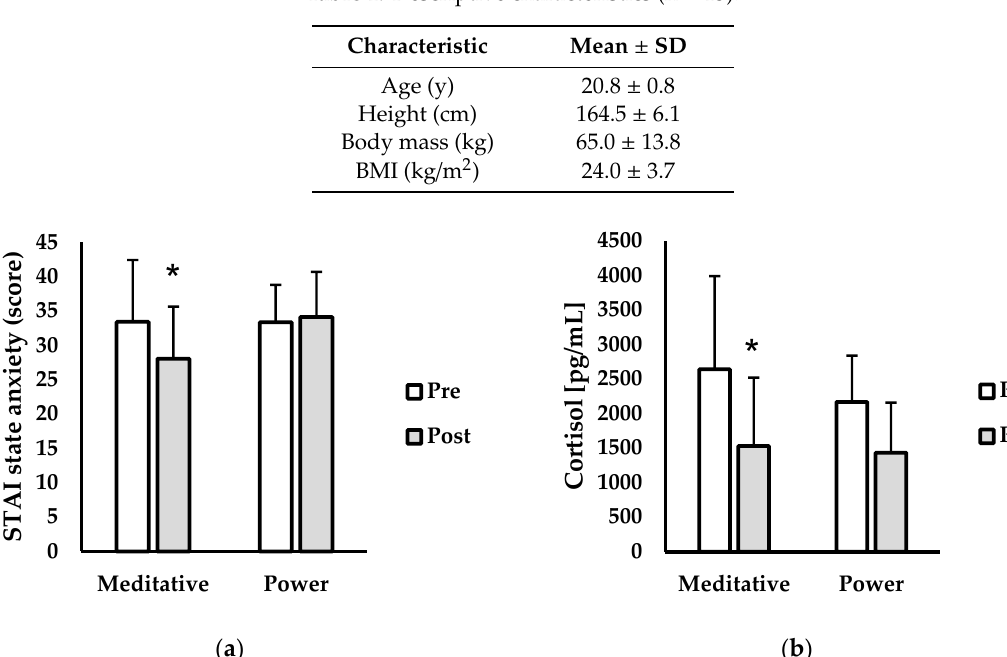
Table 1. Descriptive characteristics (n = 13).